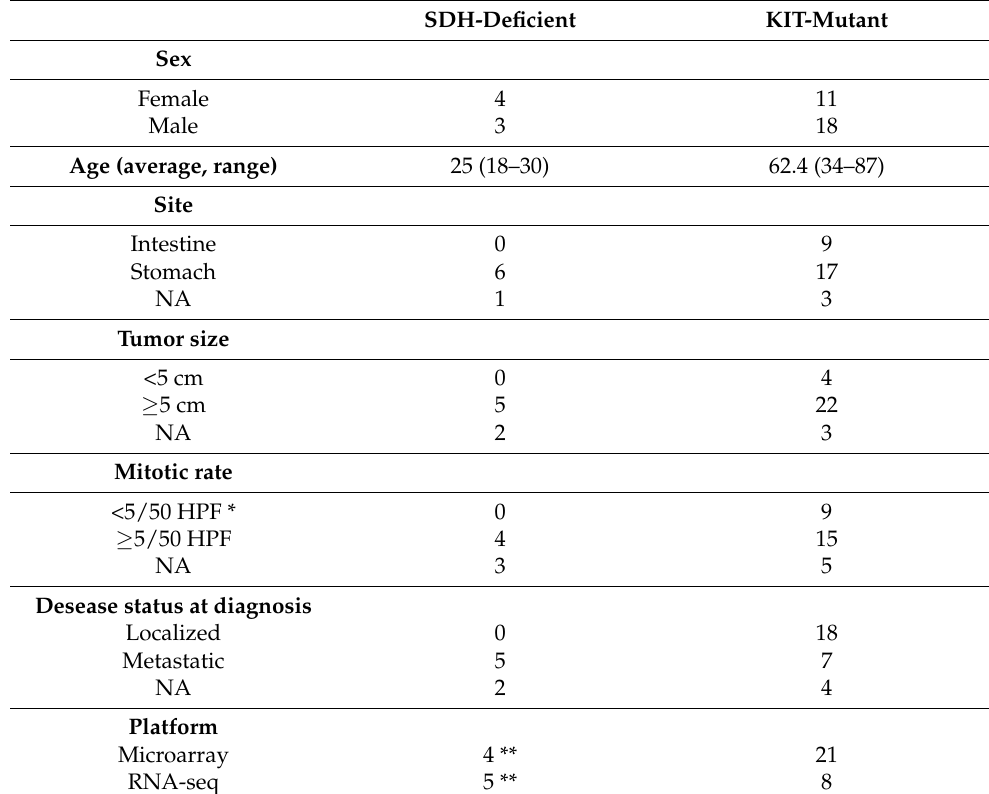
Table 1. Summary of characteristics of patients with succinate dehydrogenase deficiency (SDH- deficient) and proto-oncogene c-Kit mutant (KIT-mutant) gastrointestinal stromal tumors